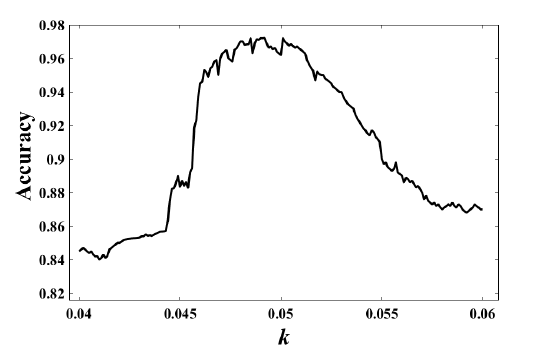
Figure 8. Performance with different parameter values, k is an constant between 0.04 and 0.06.